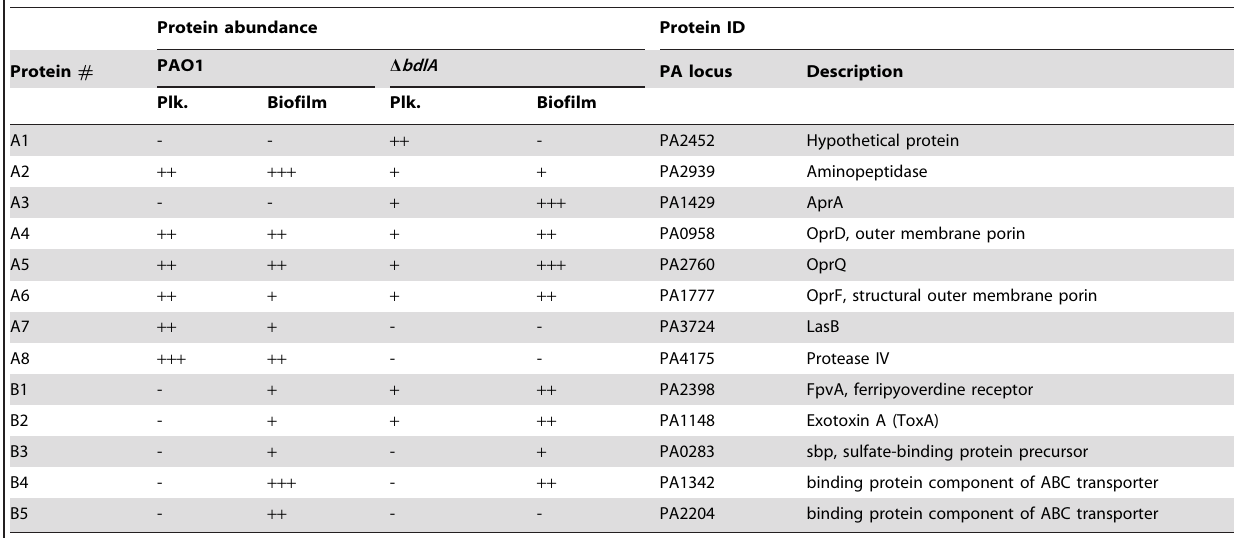
Table 1. Identification of proteins present in supernatants.